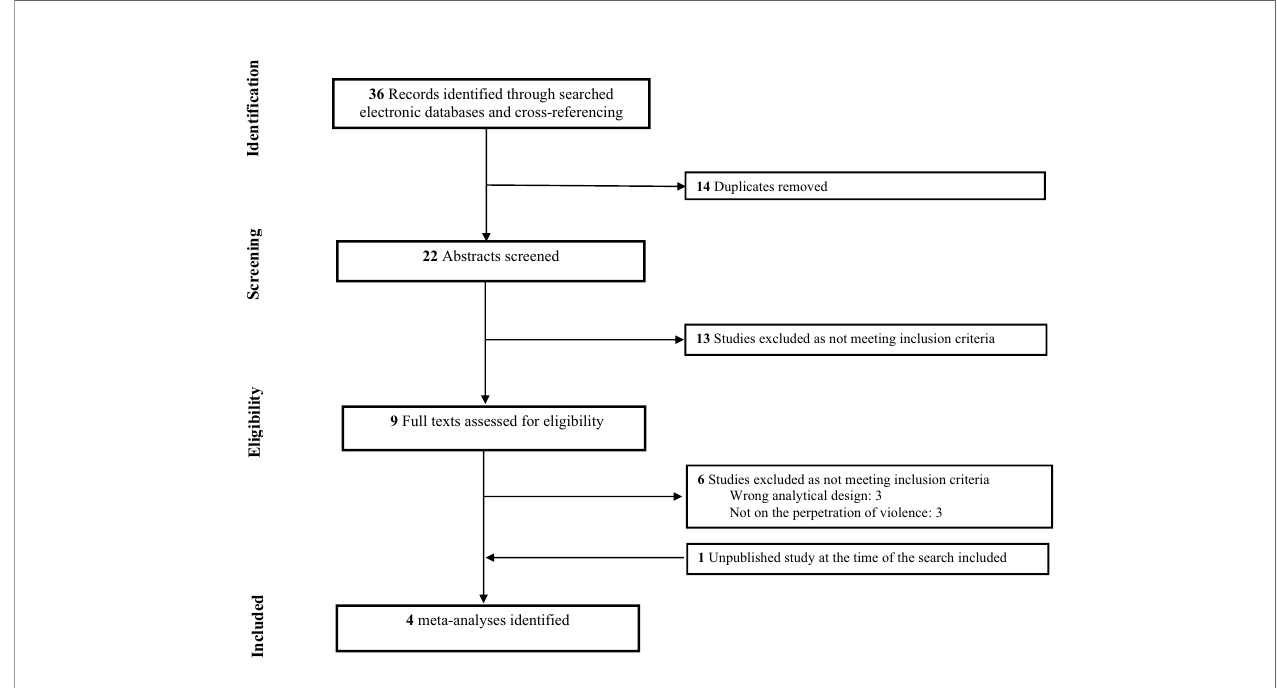
FIGURE 1 | Flow-chart depicting the search strategy employed to fi nd the meta-analyses included in this